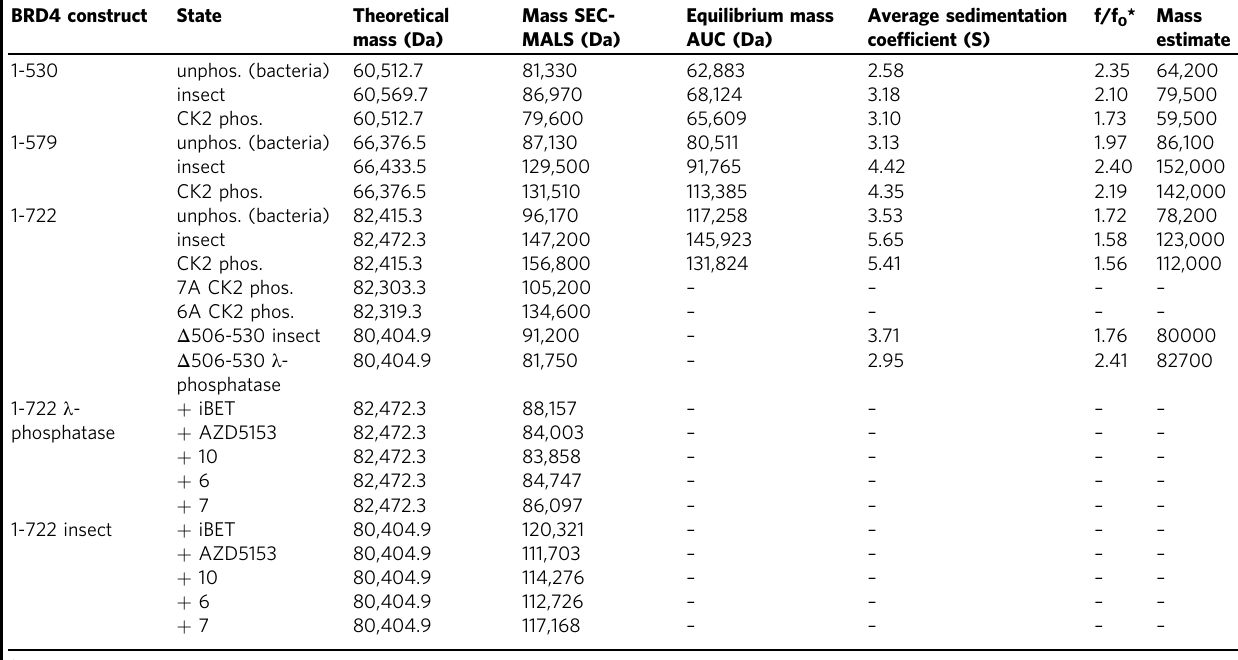
Table 1 Summary of the SEC-MALS and AUC sedimentation velocity and equilibrium experiments. BRD4